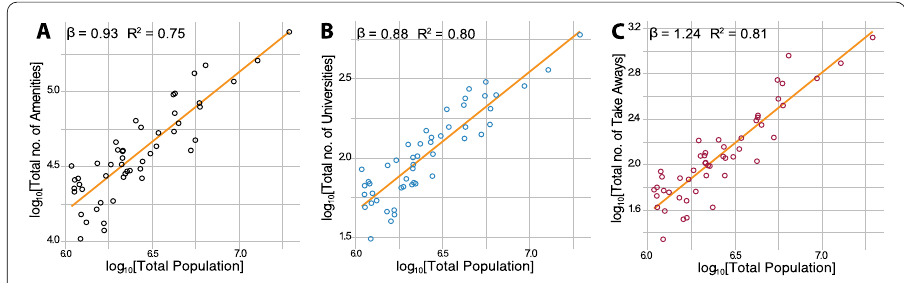
Figure 1 Scalingofquantitiesofamenitiesandpopulation . The total population size ( x -axis) and total number of amenities in a city ( y -axis) show a good linear fit on a double logarithmic scale ( A ). The same is true for single amenity types such as universities ( B ) and take-away restaurants ( C